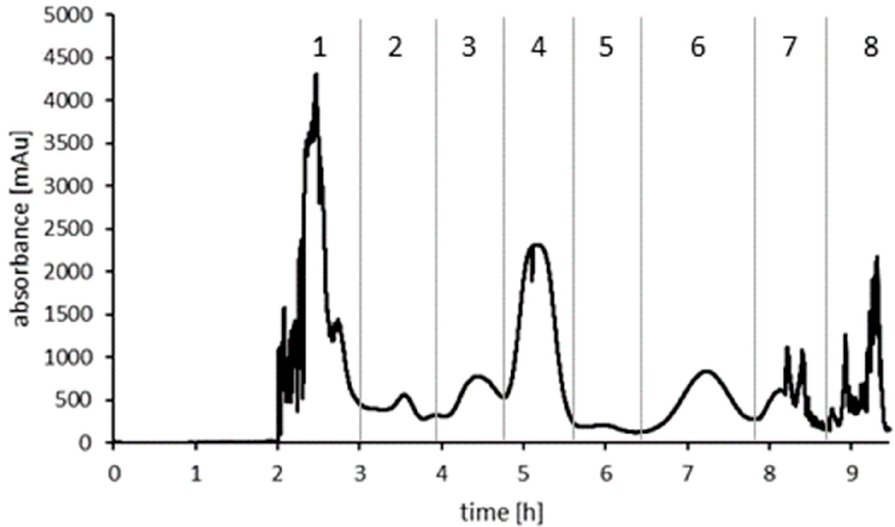
Figure 2. HSCCC chromatogram of the ethyl acetate fraction. Vertical lines represent combined fractions.